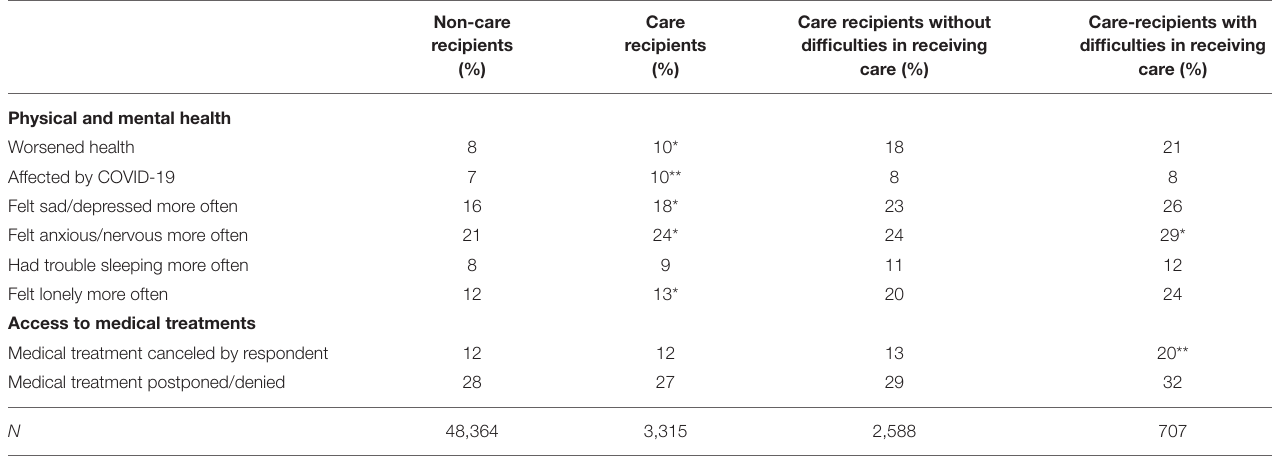
TABLE 2 | Adjusted predictions of health-related outcomes by care receiving and difficulties in receiving care. Non-care